Question: Provide a publication-style caption for this figure.
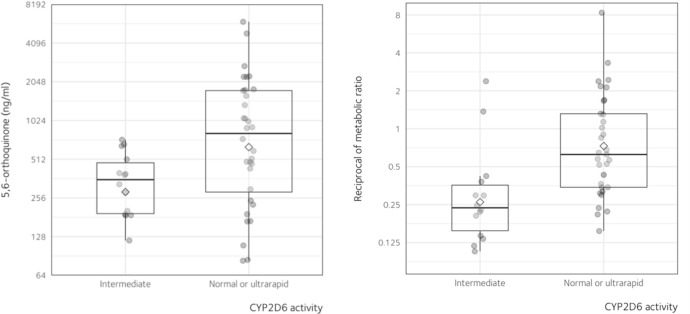
Answer: Boxplots of 5,6-OQPQ concentrations (left) and the reciprocal of metabolic ratio (5,6-OQPQ/PQ) (right) by CYP2D6 phenotype. 5,6-OQPQ concentrations vs CYP2D6 activity group: geometric-mean ratio 2.24 (95% CI: 1.26–3.98), P value 0.01, coefficient correlation: r = 0.35 (95% CI: 0.2–0.57), R 2 = 0.11 (95% CI: 0.01–0.29). 5,6-OQPQ/PQ vs CYP2D6 activity group, geometric-mean ratio: 2.83 (95% CI: 1.54–5.04), P value 0.001, coefficient correlation: r = 0.50 (95% CI: 0.22–0.71), R 2 = 0.11 (95% CI: 0.01–0.30).